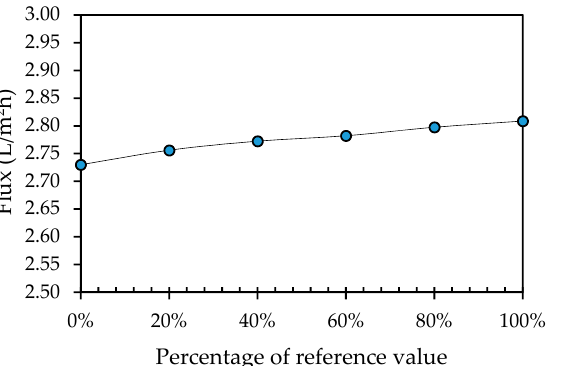
Figure 11. Total permeate flux leaving the module plotted as a function of the percentage of the reference value (100% corresponds to 0% curviness, 80% to 20% curviness, 60% to 40% curviness, 40% to 60% curviness, 20% to 40% curviness).